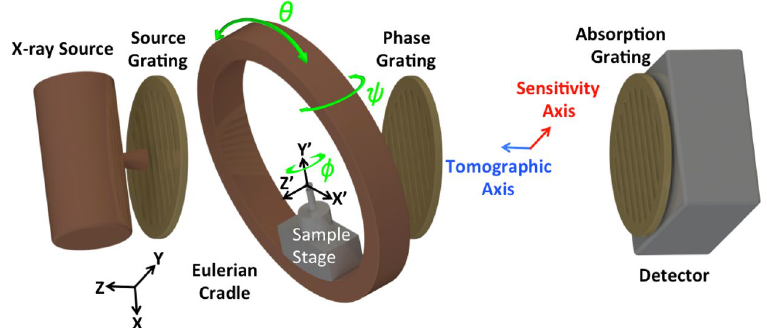
Figure 1. Schematic of a grating interferometer setup, as used in X-ray Tensor Tomography (XTT) and Anisotropic Dark-field Tomography (AXDT), showing a non-standard acquisition pose and the three axes of rotation. Figure by Sharma et al . 22 is licensed under https://creativecommons.org/licenses/by/4.0/CC BY